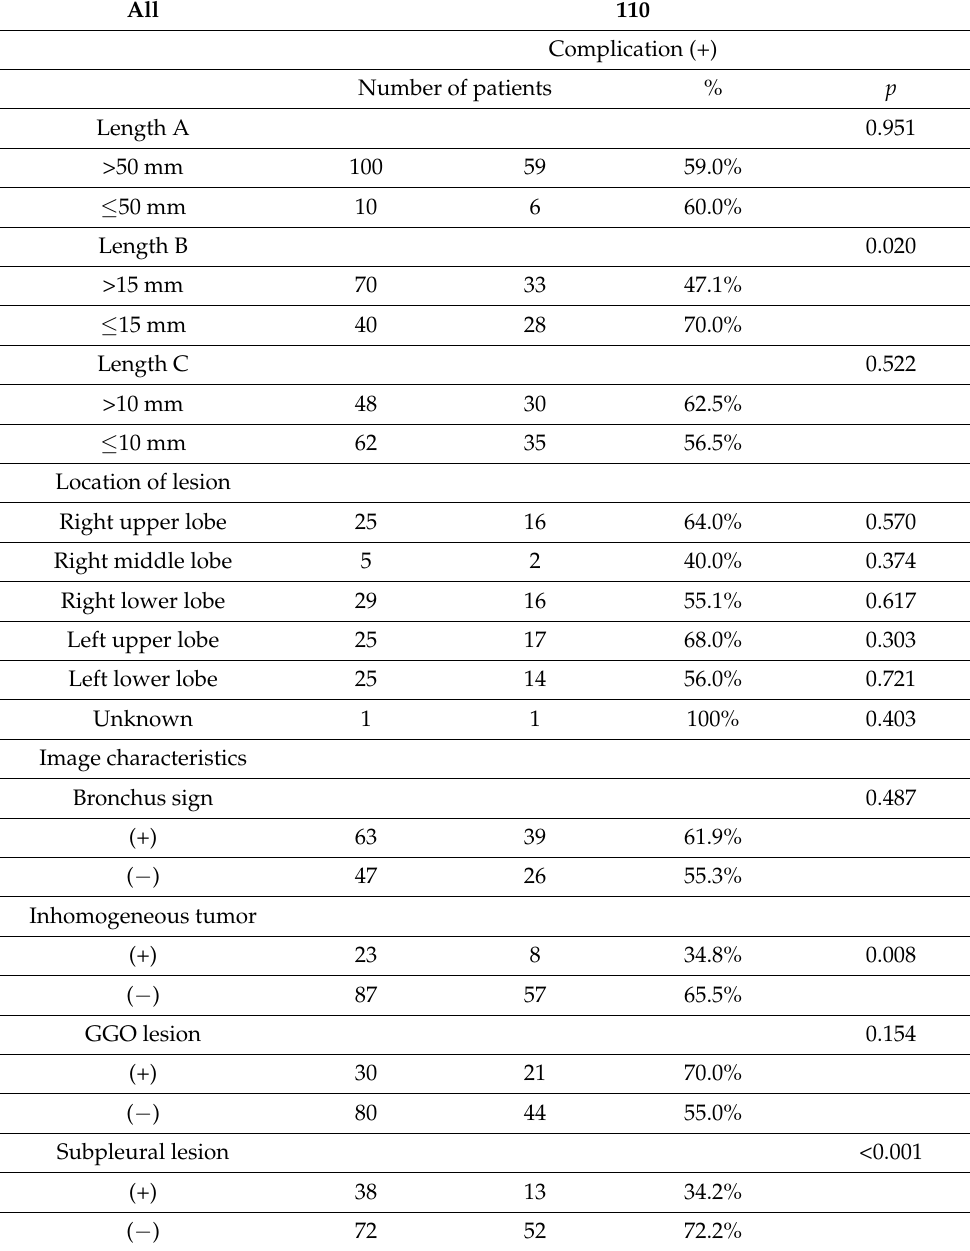
Table 6. Complications of CT-GNB in relation to target